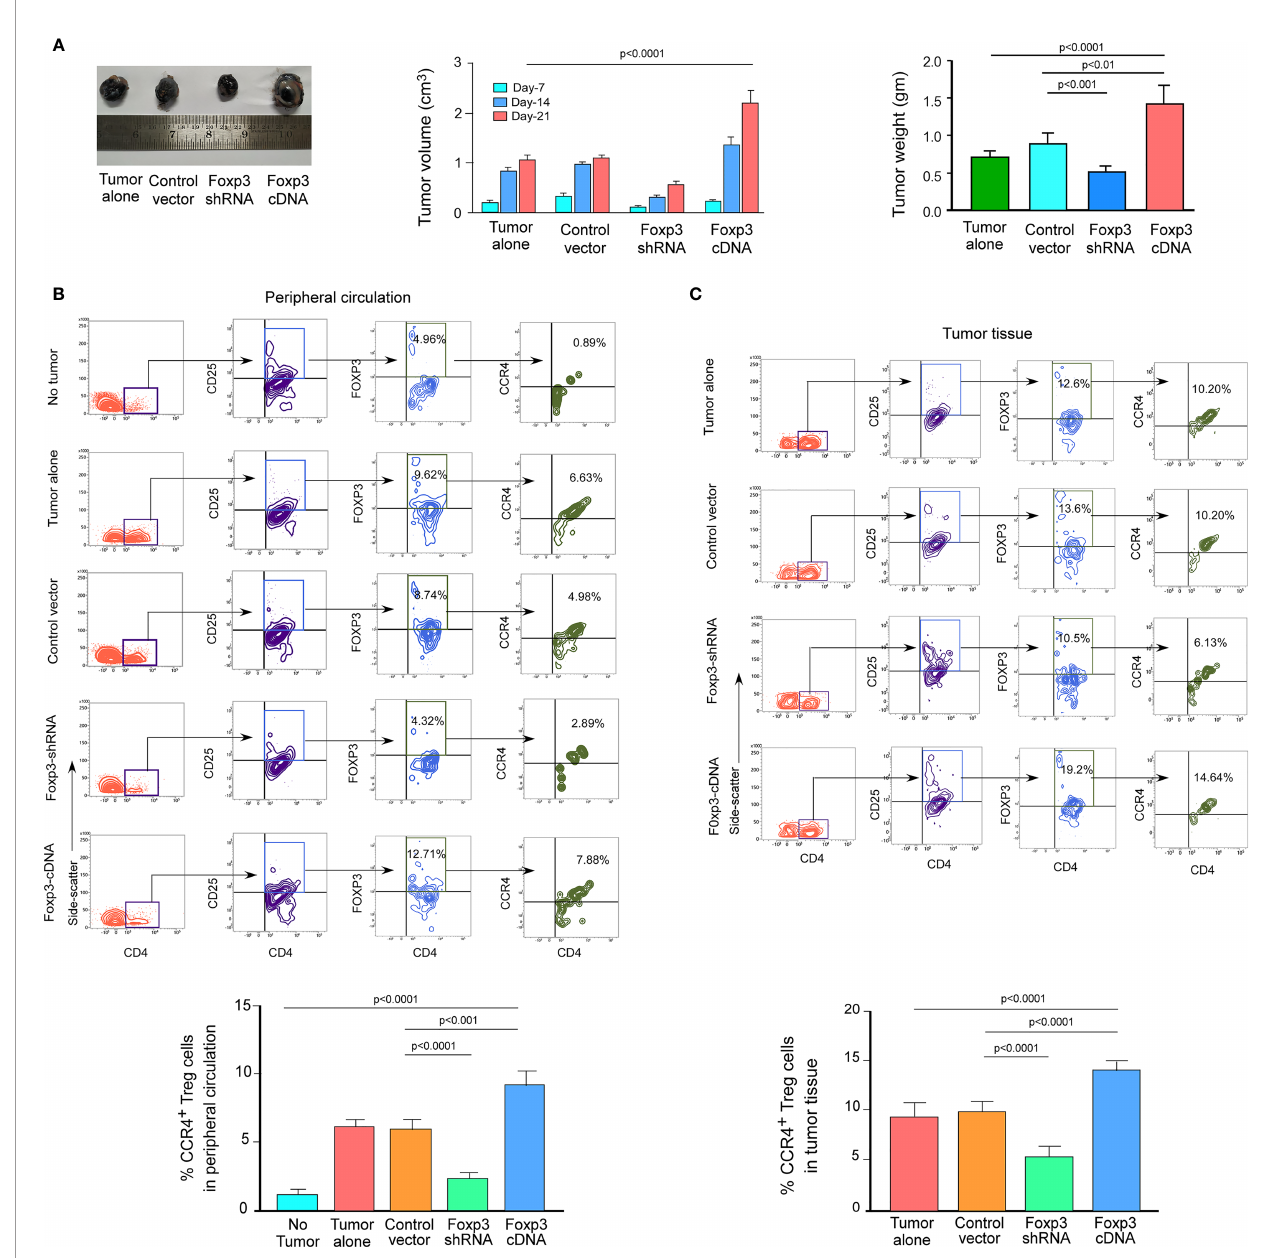
FIGURE 6 | FOXP3 regulates Ccr4 transcription and in fi ltration of Tregs in mouse melanoma site. (A) Foxp3-shRNA or Foxp3-cDNA lentiviruses were injected into the tail veins of B16/F10 melanoma-transplanted C57/BL6 mice ( n = 6). Mice were sacri fi ced after 21 days, and the tumor was detached (left panel). The volume and weight of the tumor were measured and graphed (middle panel, right panel). CCR4 and FOXP3 positivity in Tregs from (B) peripheral circulation and (C) tumor site were fl ow cytometrically analyzed (upper panels) and graphically plotted (lower panels). The values are the mean ± SD of two sets of independent experiments performed in